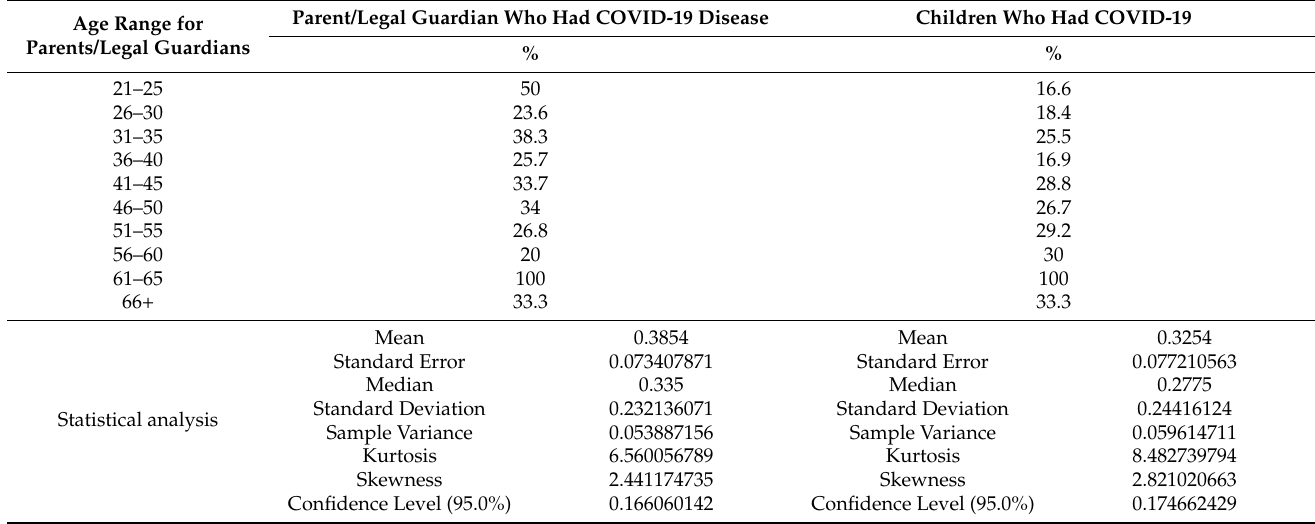
Table 3. Infections with COVID-19 disease of respondents and their